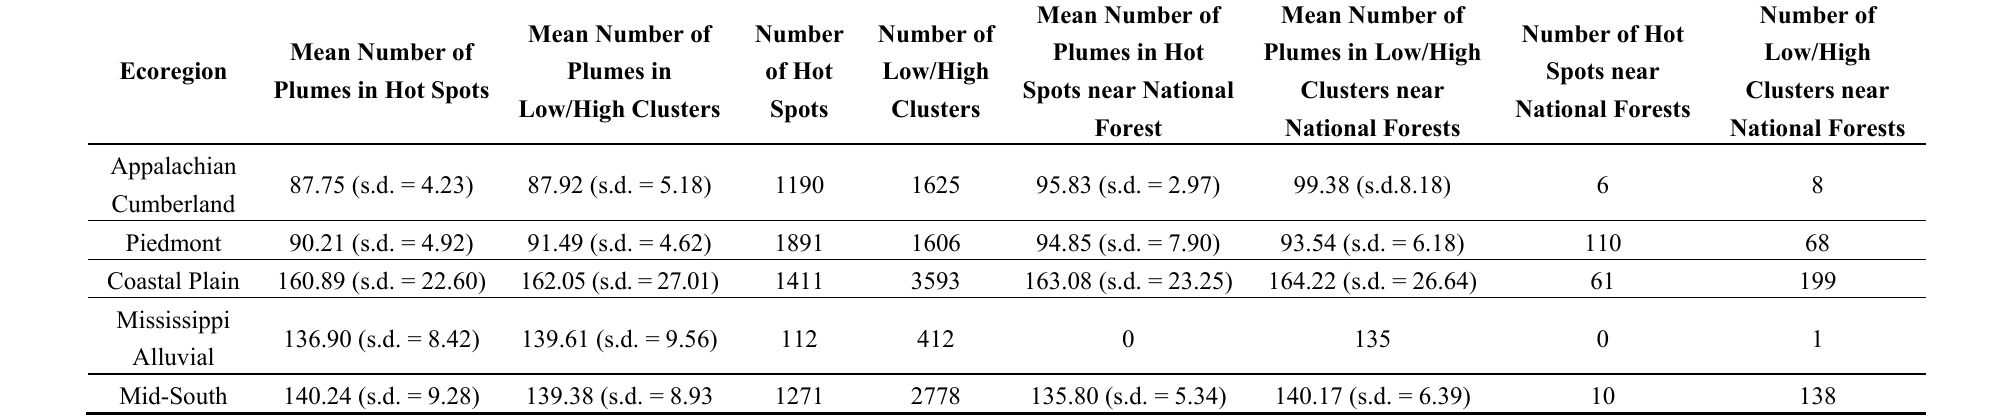
Table 7. Mean plume county in hot spot and low/high clusters generally and within 1 mile of a National Forest. Number of hot spots and low/high clusters generally and within 1 mile of a National